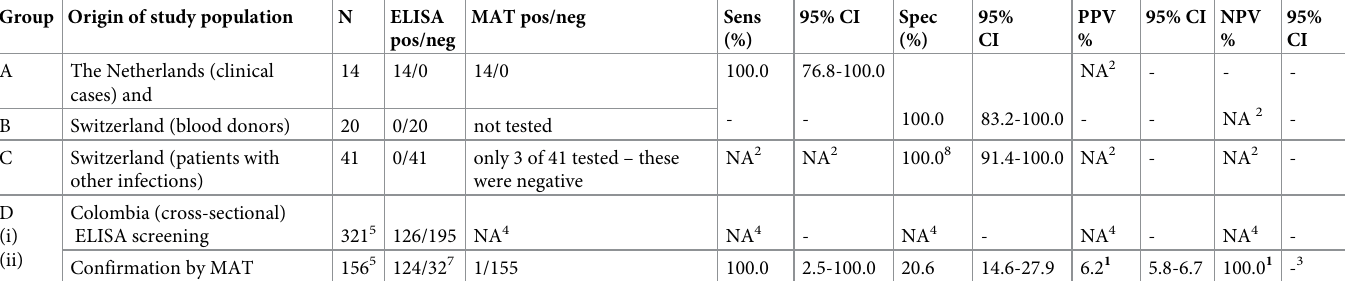
Table 4. Performance of the Serion IgM ELISA (REF EST125M) tested with sera from persons from the Netherlands, Switzerland, and Colombia with different dis- ease/exposure status compared to the results of the MAT, calculated by the MedCalc online tool (https://www.medcalc.org/calc/diagnostic_test.php). Group Origin of study